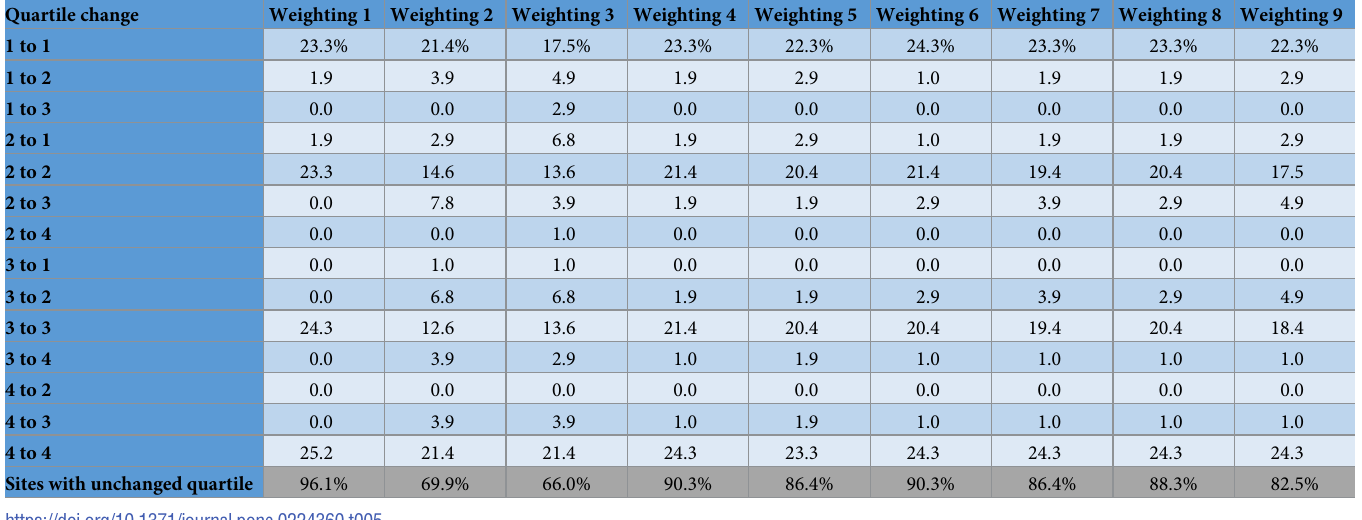
Table 5. Percent of sites that changed or maintained their resilience quartiles under nine indicator weighting systems in comparison with unweighted indicators (n = 103). For descriptions of each weighting system, refer to Table 1. Quartile 1 is the quarter of sites with the highest resilience; quartile 4 is the quarter of sites with the lowest resilience.